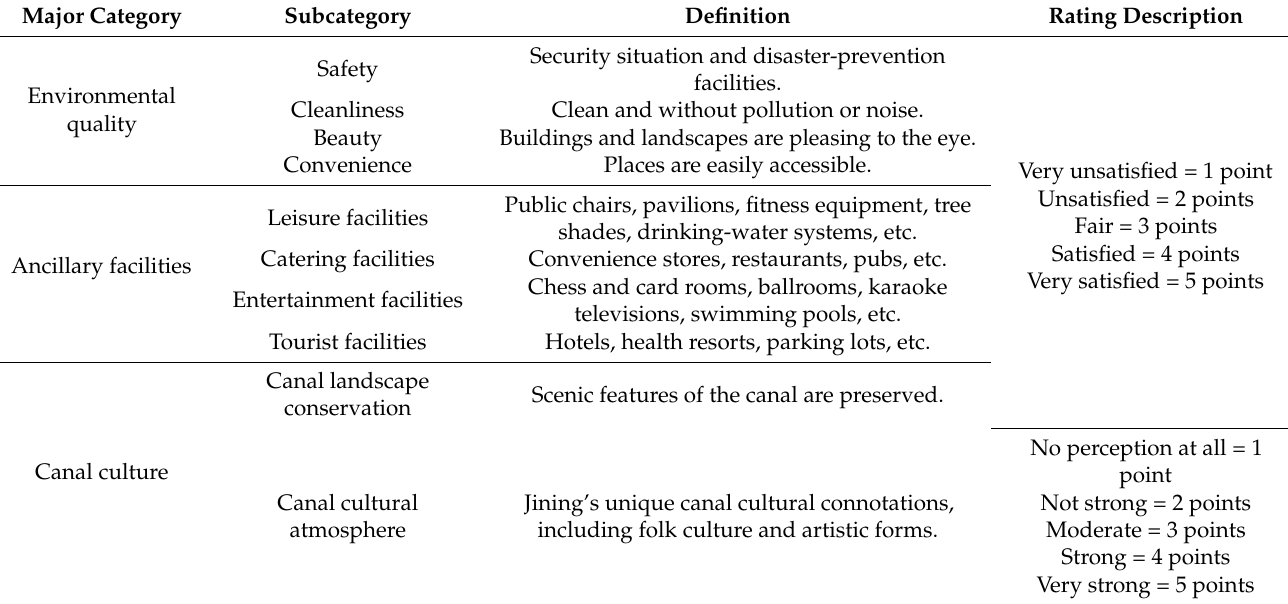
Table 1. Classification and definition of subjective factors evaluating urban spaces in